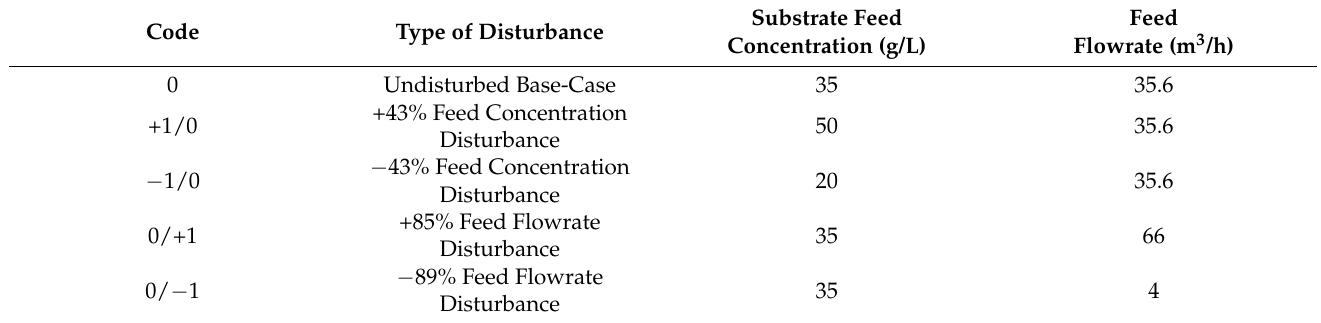
Table 2. Inputs variations for sensitivity analysis (Base-Case is code